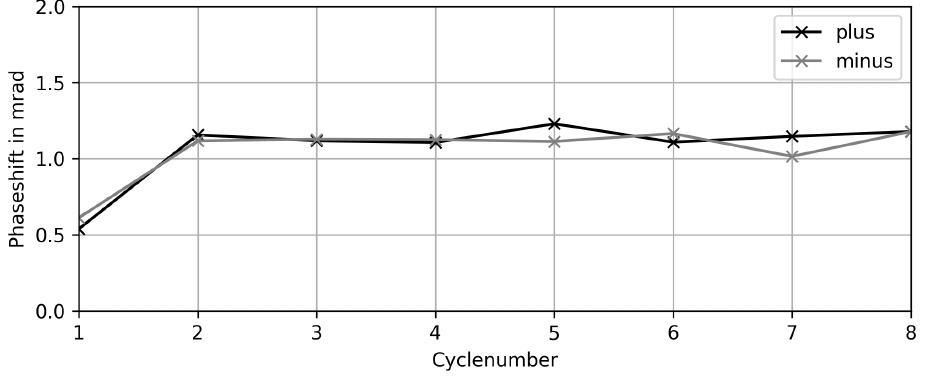
Figure 14. Phase shift of the displacement signal.